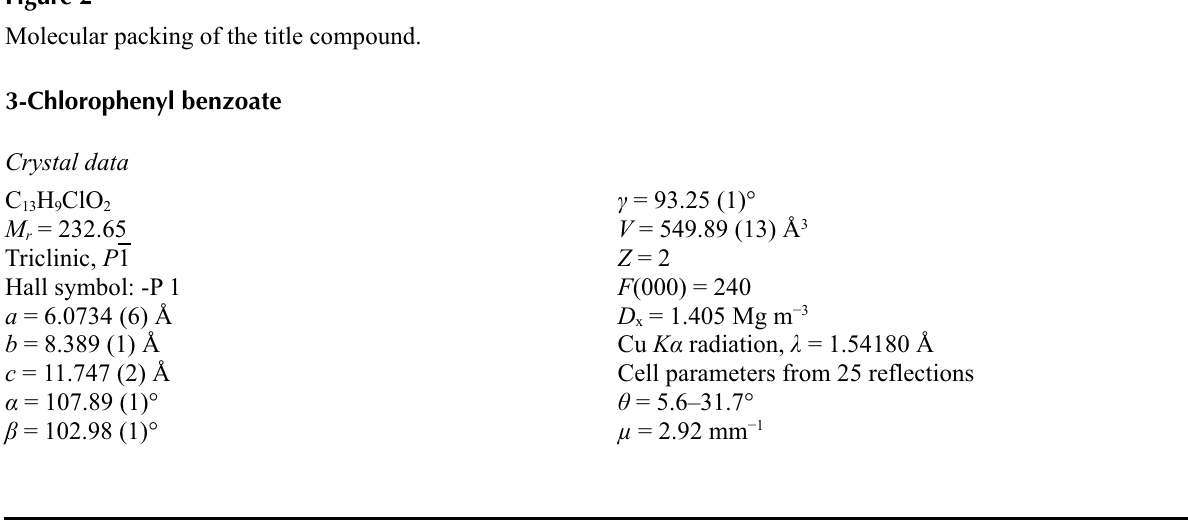
Molecular packing of the title